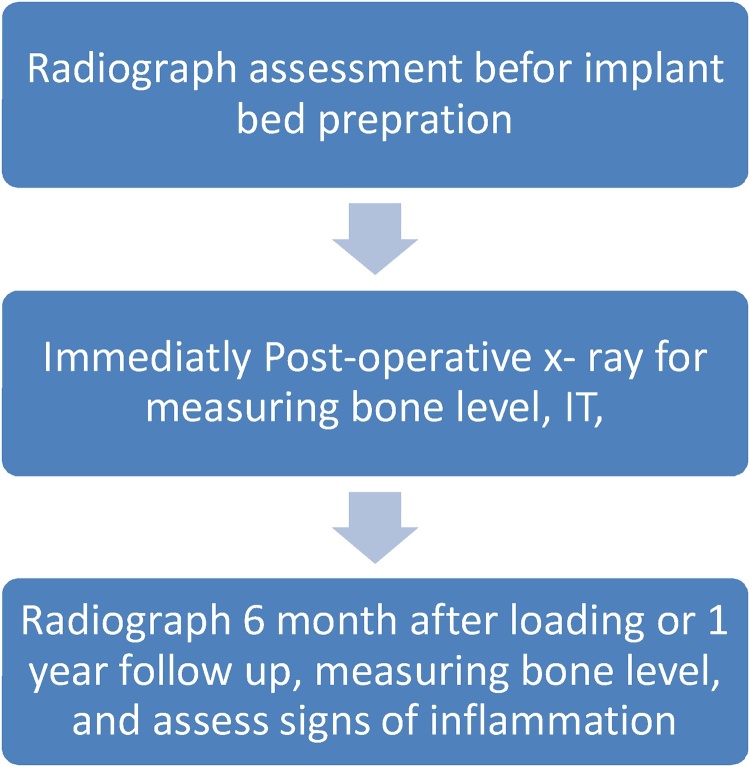
Timeline for assessment of implant and radiographs.